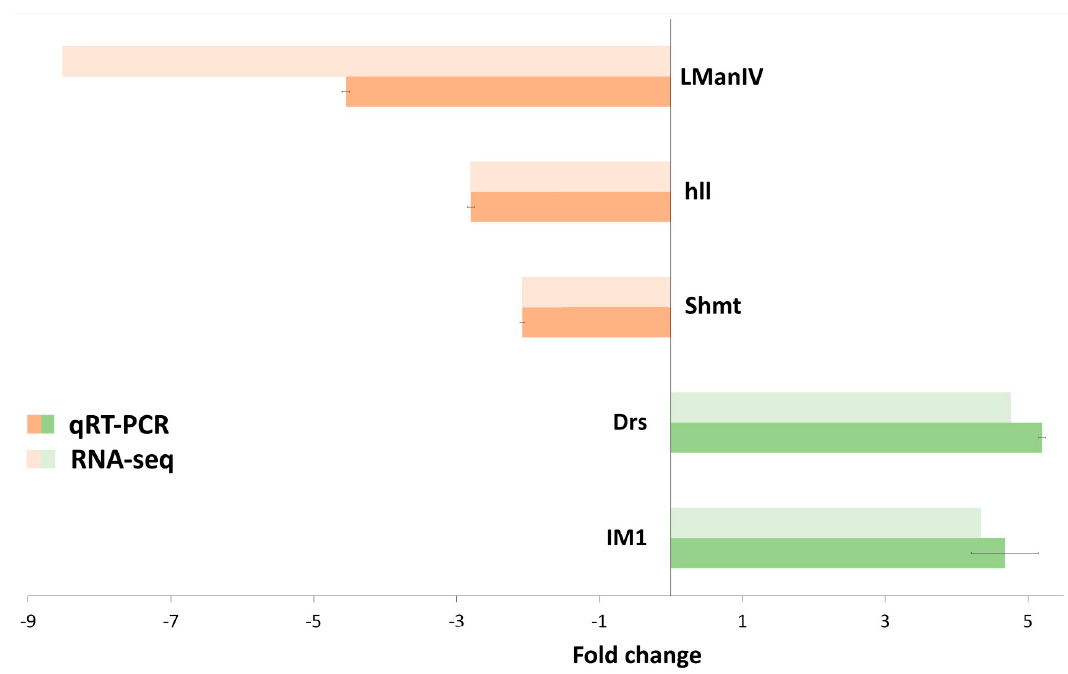
Fig 4. Validation of the RNA-seq results by the RT-qPCR analysis. The bar graphs represent the fold change in gene expression in the LB-flies vs. NB-flies. For all values p < 0.05.